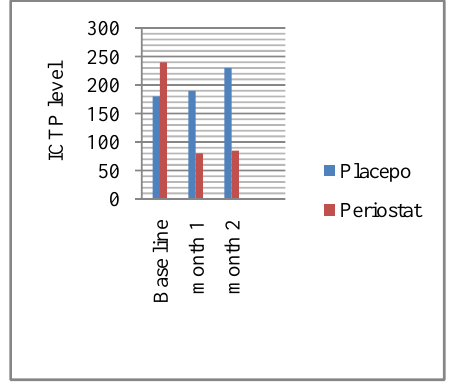
Figure1: Effect of sub-antimicrobial-dose Doxycycline (SDD) on gingival crevicularfluid (GCF) collagenase (MMP-8, MMP-13) and